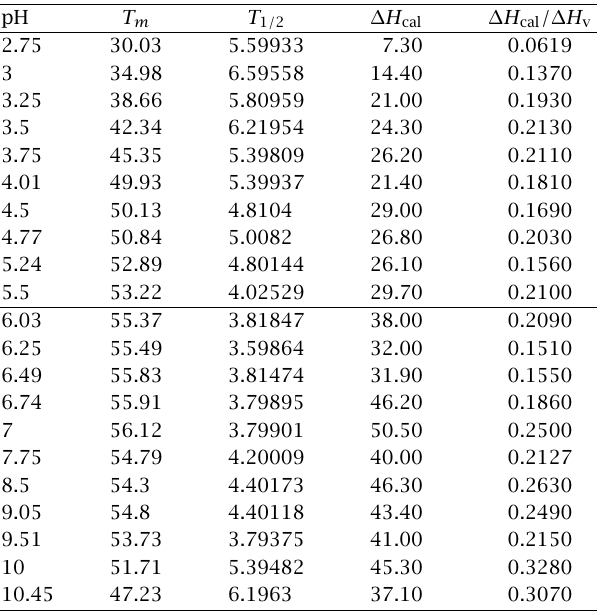
Table 1: pH dependence profile of native Cutinase. Native Cutinase shows refolding up to pH 5.5. Beyond pH 6.0 no refolding is seen in DSC experiments due to irreversible self aggregation. T 1 / 2 denotes the peak halfwidth, ∆ H cal is the calorimetric enthalpy and ∆ H vh is the vant Hoff enthalpy. The enthalpy values are given in